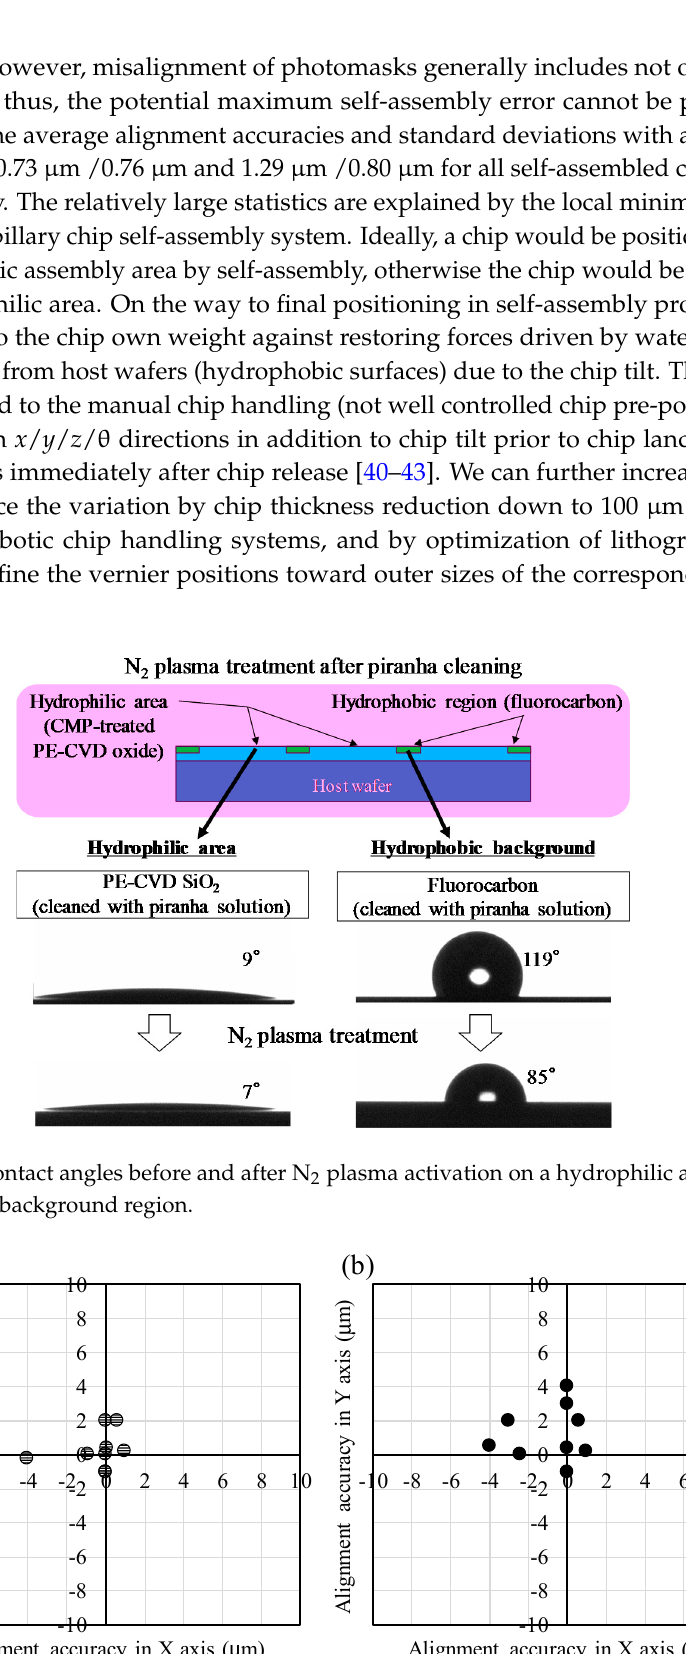
Figure 7. Alignment accuracies of self-assembled chips before and after thermal compression of MCtW direct bonding.